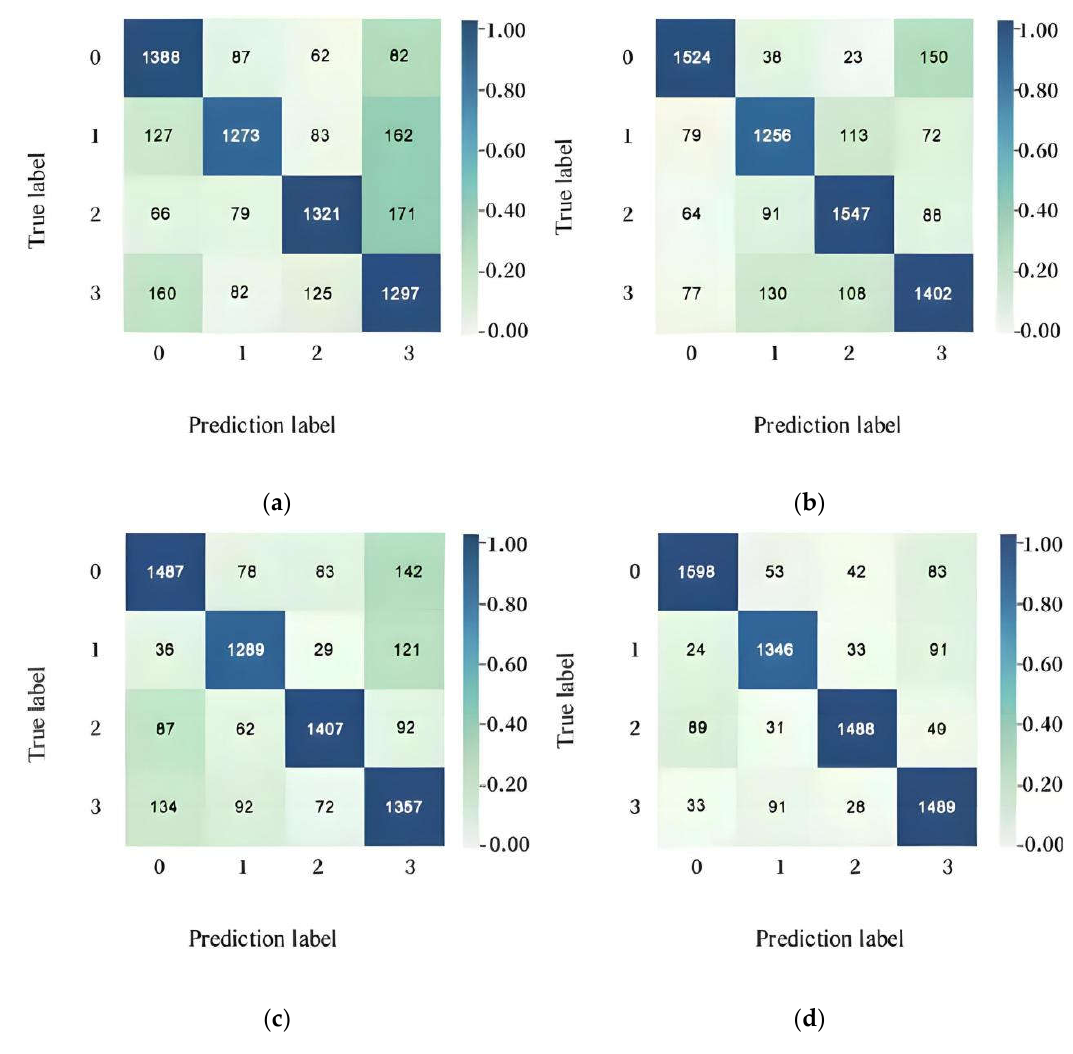
Figure 6. Comparison experiment diagram of confusion matrix. ( a ) AlexNet; ( b ) ResNet; ( c ) YOLOv4; ( d ) CCA-YOLO.